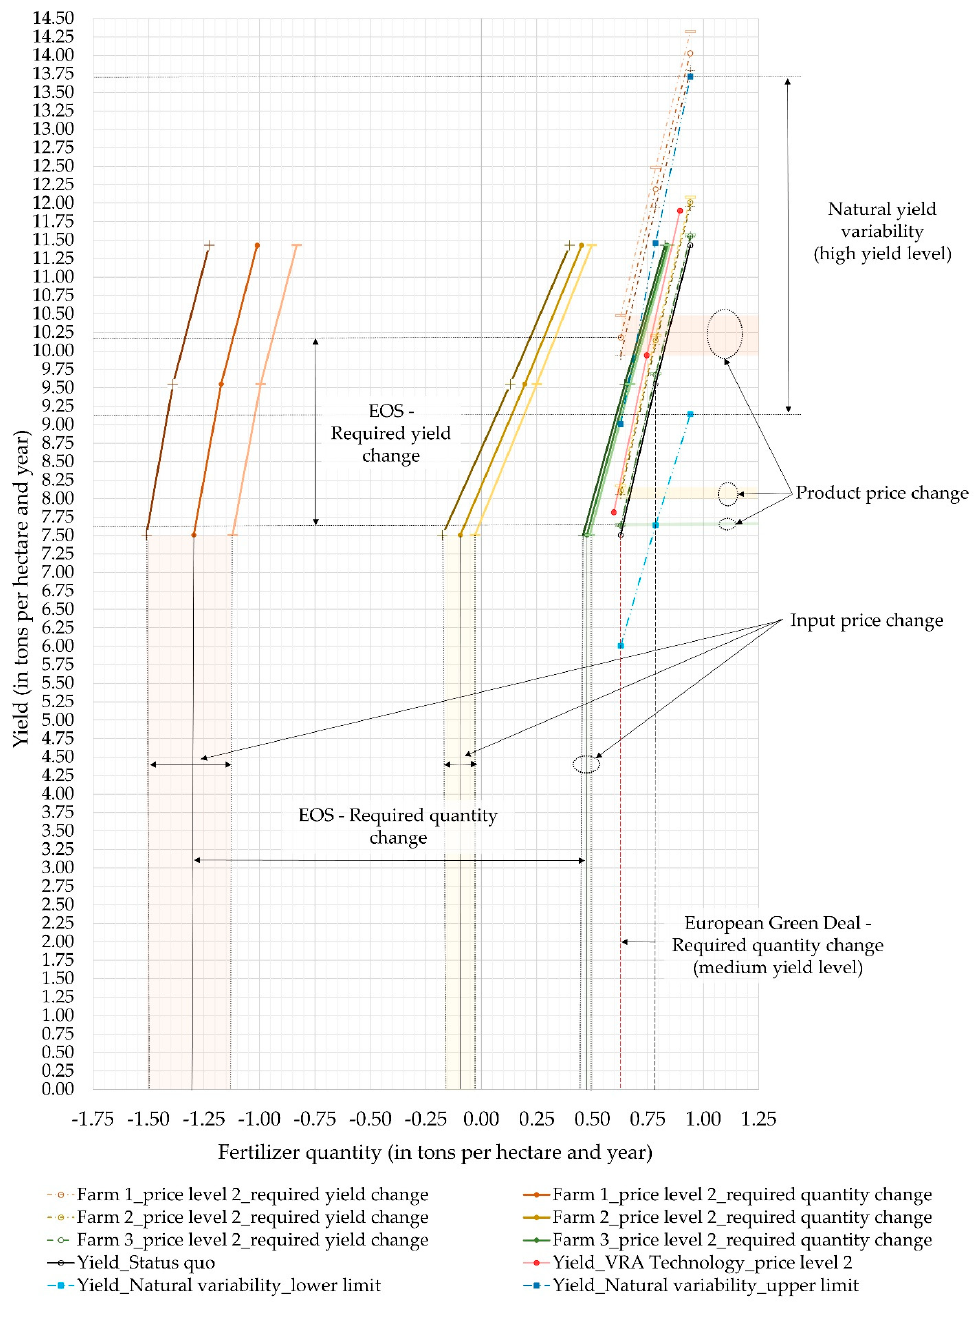
Figure 4. Necessary shift in production functions of Farms 1–3 to cover the additional costs of using the variable-rate technology in the face of changes in product price, input price and natural variation in yields.